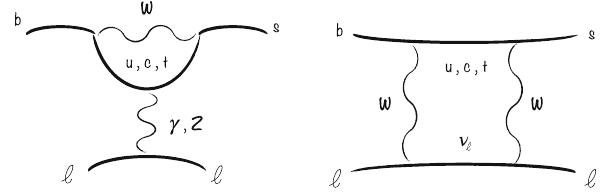
Fig. 1 Penguinandboxdiagramsgivingriseto b → s (cid:2) + (cid:2) − transitions in the